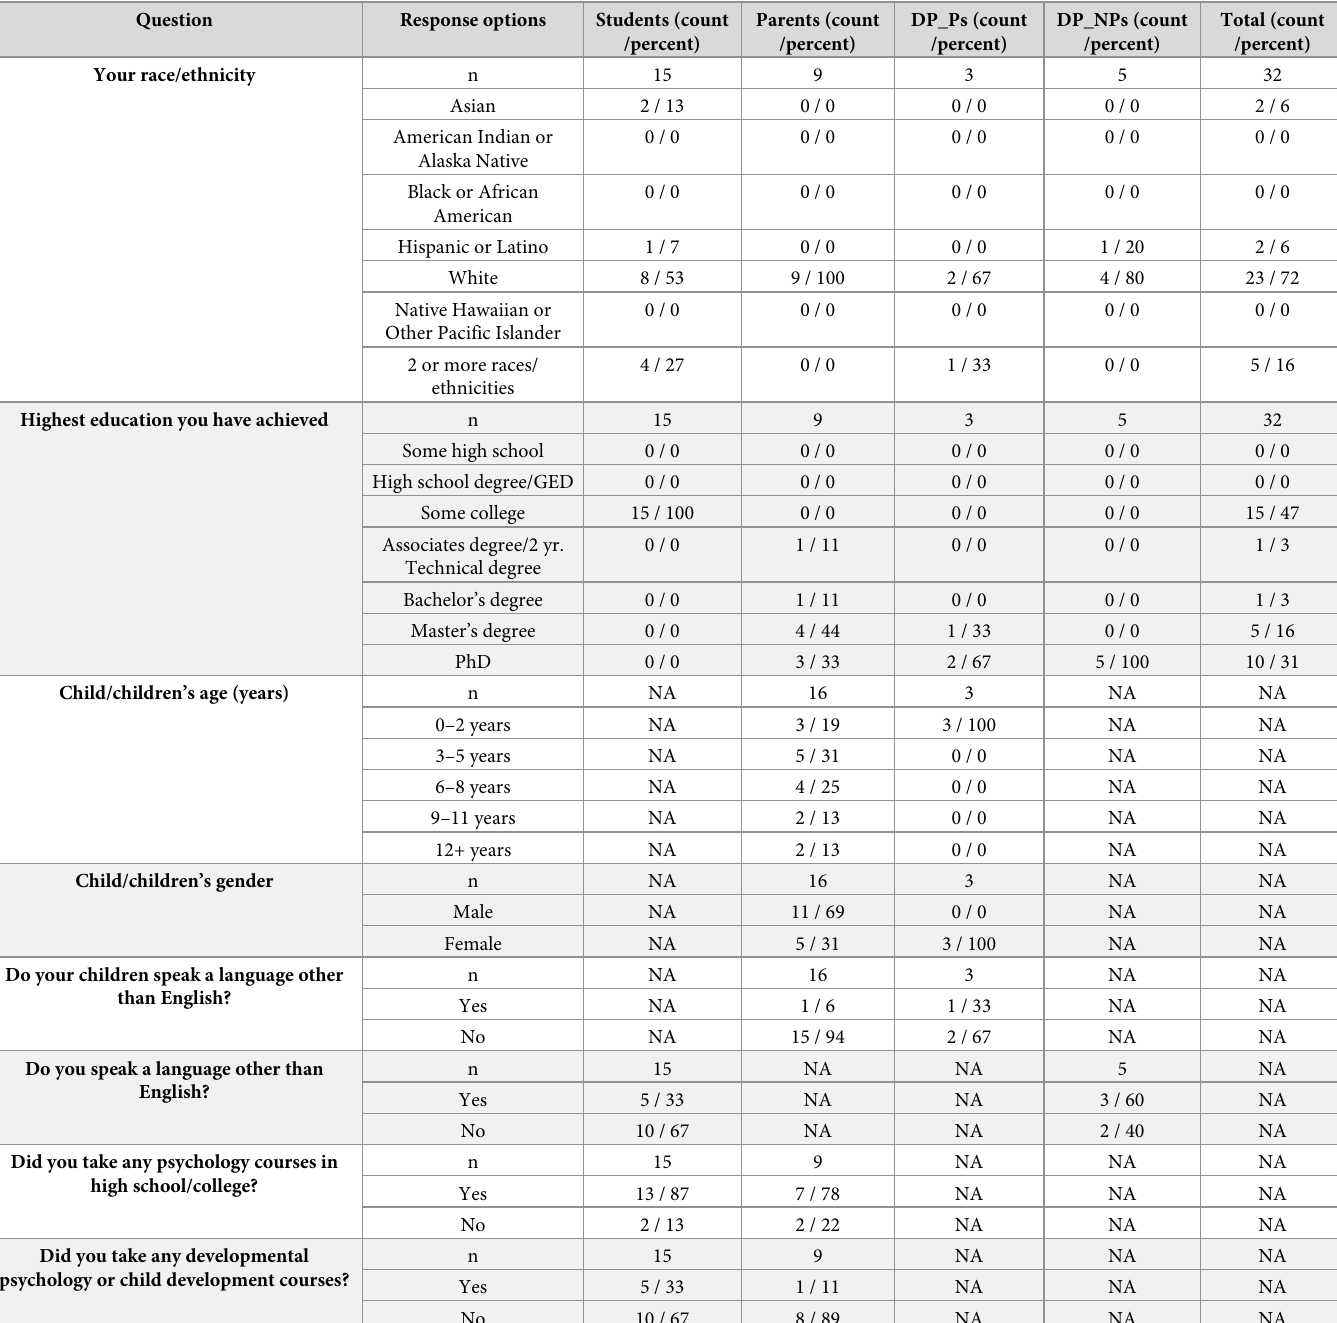
Table 1. Demographics of study